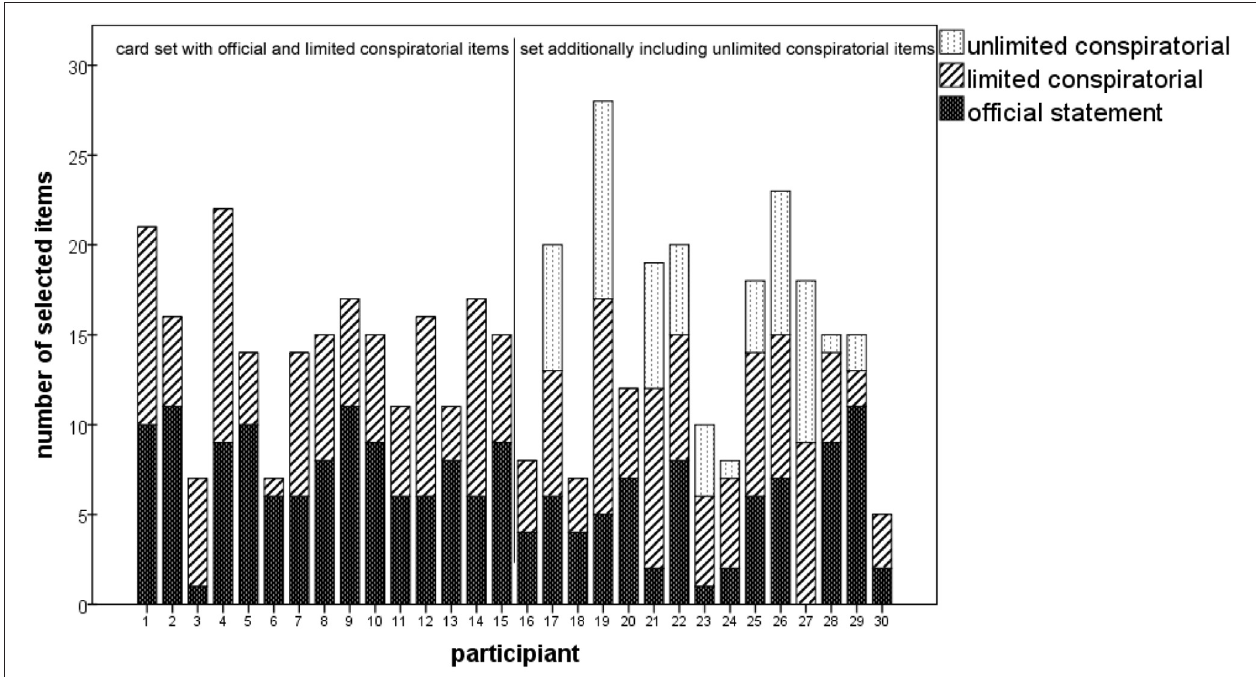
FIGURE 1 | Each participant created a unique story, blending official, limited, and unlimited conspiratorial items to build a plausible 9/11 narrative.